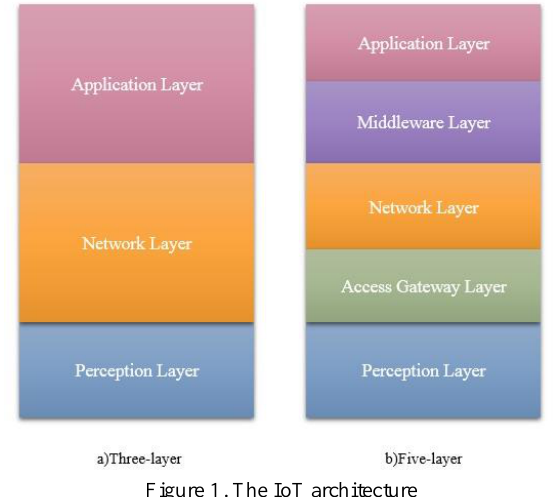
Figure 1. The IoT architecture